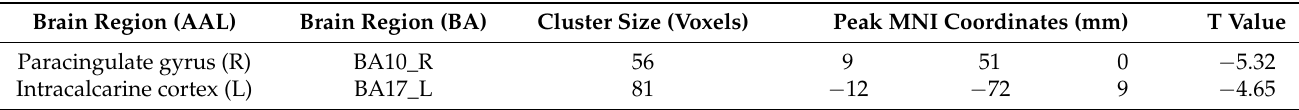
Table 2. Significant differences in regional fALFF between TP1 and TP2.